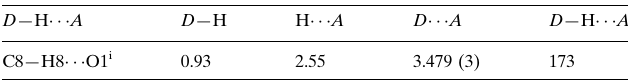
Hydrogen-bond geometry (A˚ , (cid:1)